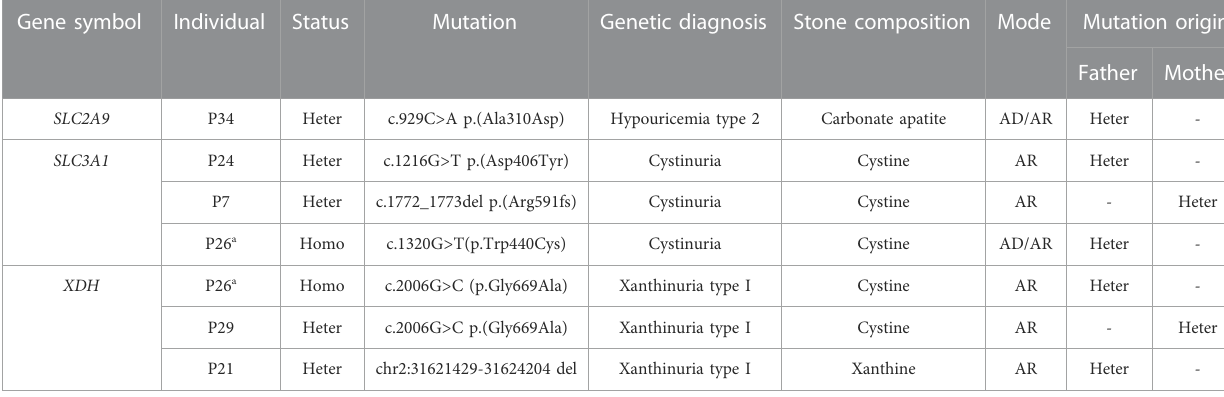
TABLE 4 Six novel variants identi fi ed by exome sequencing.